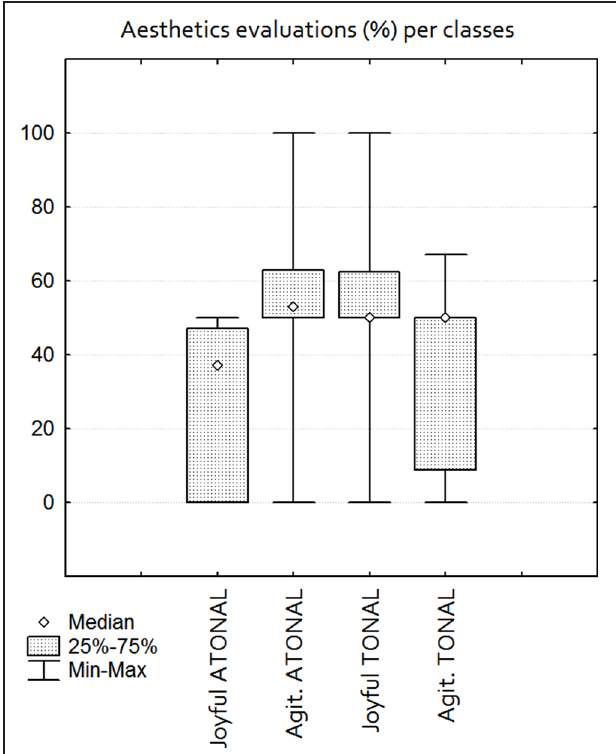
FIGURE 3 | Results of the paired-samples Wilcoxon rank-sum test applied to the percentage of agitating vs. joyful evaluations attributed to pieces belonging to the two repertoires. Atonal pieces were judged to be significantly more agitating (i.e., as inducing tension) than tonal pieces, which were more frequently labeled as joyful . No difference whatsoever was found in the frequency with which a piece was judged to be touching (i.e., able to induce pathos) across the two repertoires. This finding is in contrast with the conclusions advanced by Kallinen (2005) that: (i) modern music does not intend to portray emotions; (ii) the meaning of musical emotional qualities in modern music is not as well-established as it is with regard to older